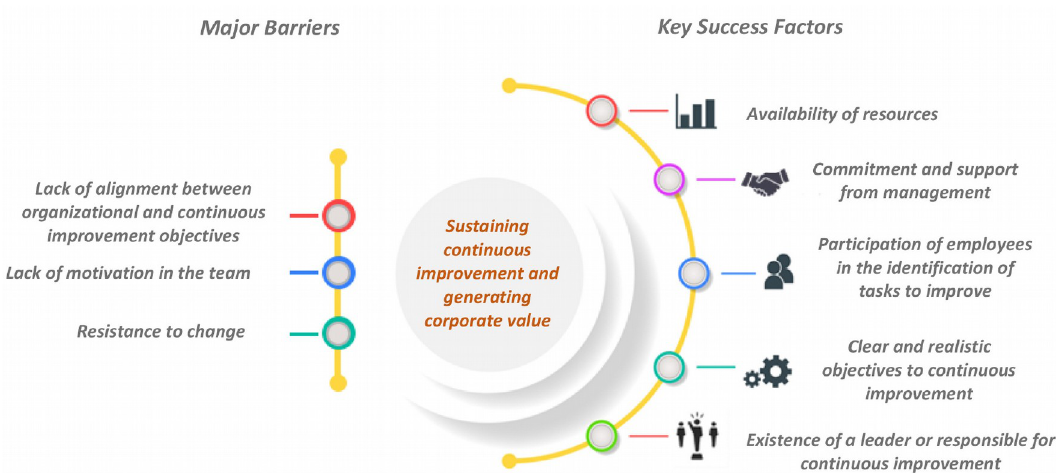
Figure 7. Key success factors and barriers for the CIS of companies of emerging